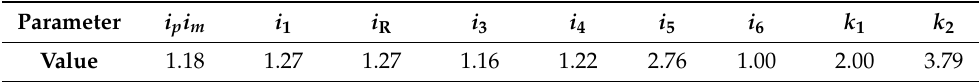
Table 1. Design values of transmission system parameters [32].